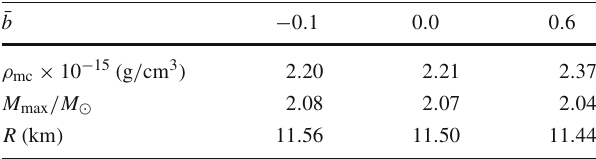
Fig. 28 Variation of M / M (cid:2) as a function of the radius R for three- form field Bose–Einstein condensate stars in the presence of a Higgs- type potential, for ¯ a = 0 . 001 and three different values of the constant ¯ b : ¯ b = 0 (dashed curve), ¯ b = − 0 . 1 (dotted curve), and ¯ b = 0 . 6 (dot- dashed curve), respectively. The solid curve represents the mass–radius relation for general relativistic Bose–Einstein condensate stars Table 8 The maximum masses and the corresponding radii for three- form field Bose–Einstein condensate stars in the presence of a Higgs- type potential for ¯ a = 0 . 001, and different values of ¯